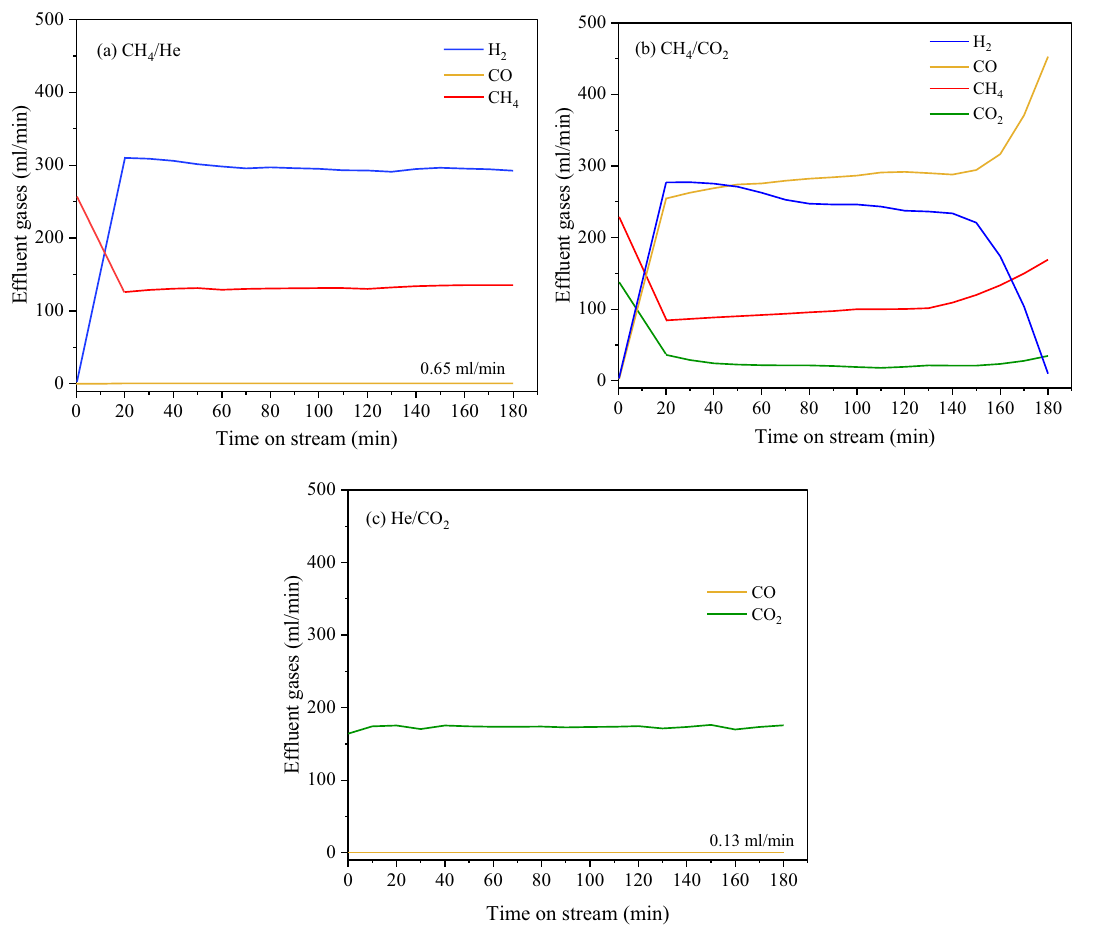
Figure 10. The composition of effluent gas at 800 °C for 3 h over FeNiMo/MgO catalyst under ( a ) CH 4 /He ( b ) CH 4 /CO 2 ( c ) He/CO 2 , GHSV = 48,000